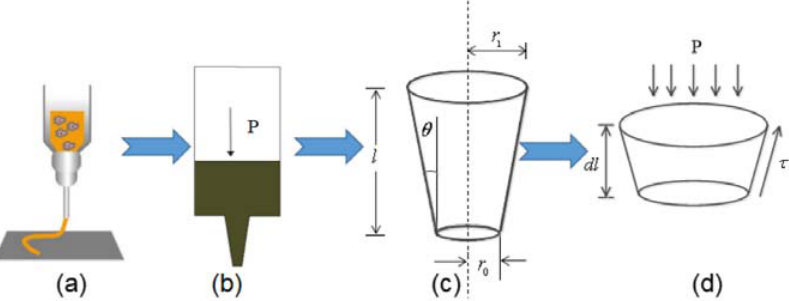
Figure 3. The simplified print head of bioplotter: ( a ) Extrusion process of composite materials; ( b ) Simplified model of composite extrusion process; ( c ) Print nozzle end model; ( d ) Shear force unit model of printing nozzle.